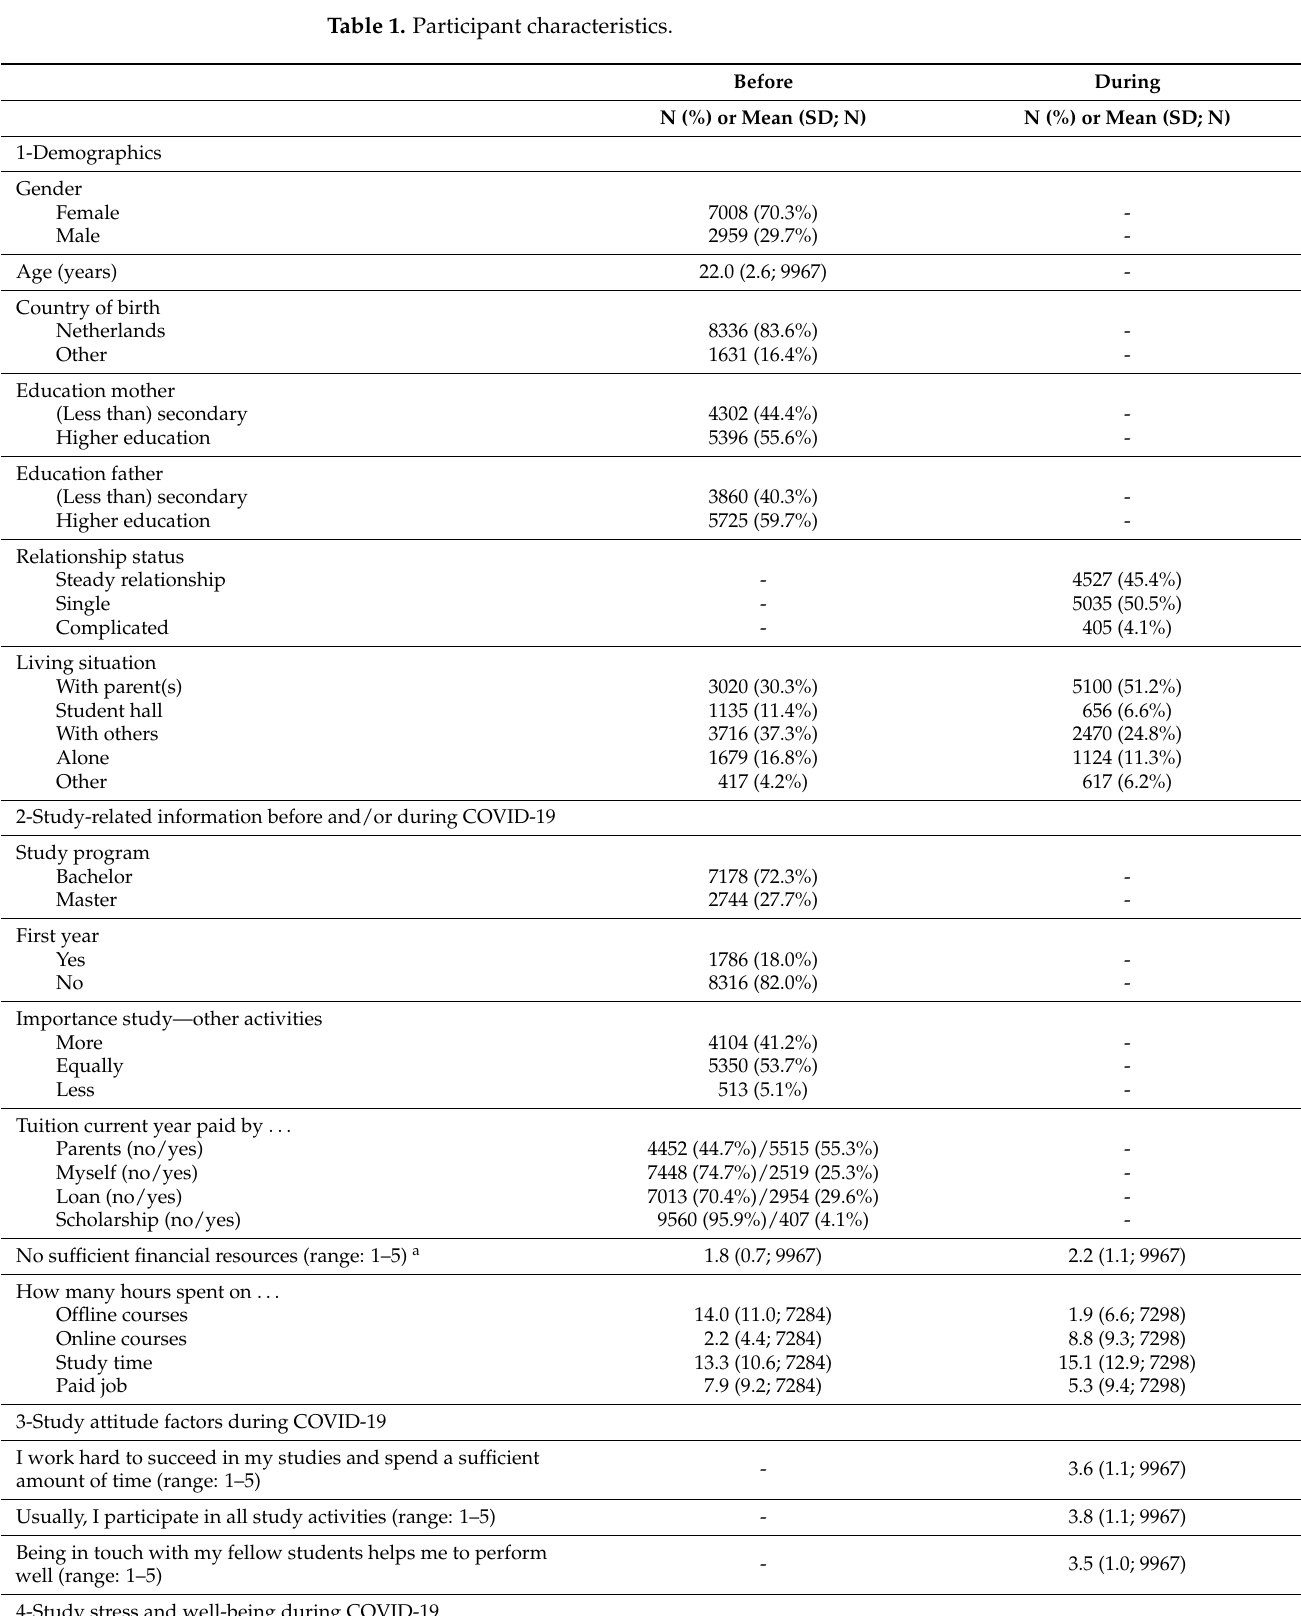
Table 1. Participant